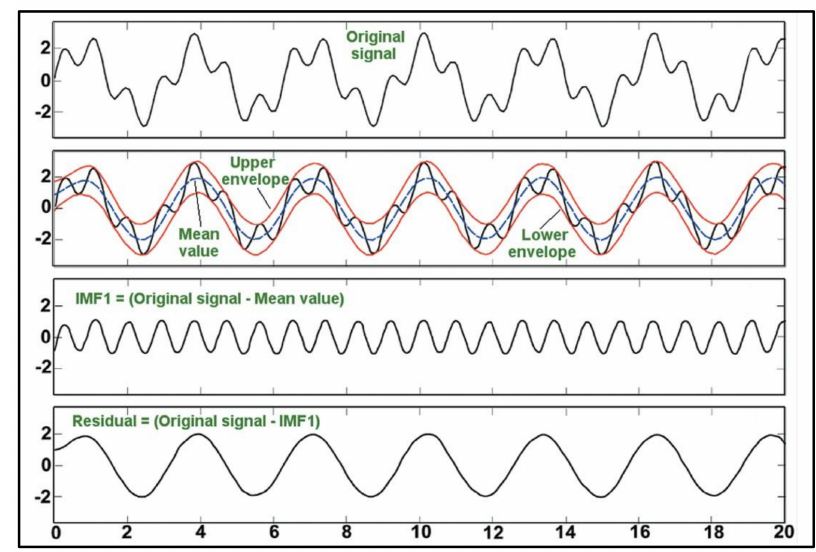
Figure 2. Data, upper and lower envelopes, and m 1 mean value